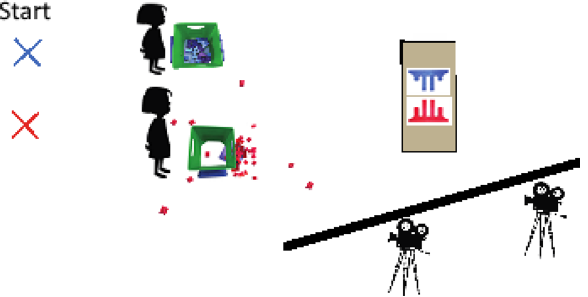
Figure 3. Layout of experimental set-up with images for the separate condition.